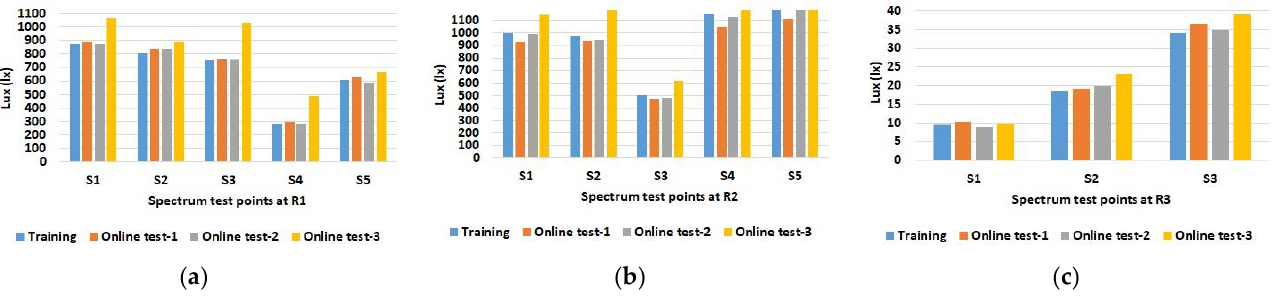
Figure 4. Determined illumination intensity (lux) for training and online test experiments at the defined spectrum test points S in room 1: ( a ) at the left with S1 to S5, room 2; ( b ) in the middle with S1 to S5, and room 3; ( c ) at the right with spectrum test points S1 to S3. As expected, the data show increased illuminance levels for spectrum test points near windows or indoor light sources. Furthermore, the increased illuminance for room 1 and